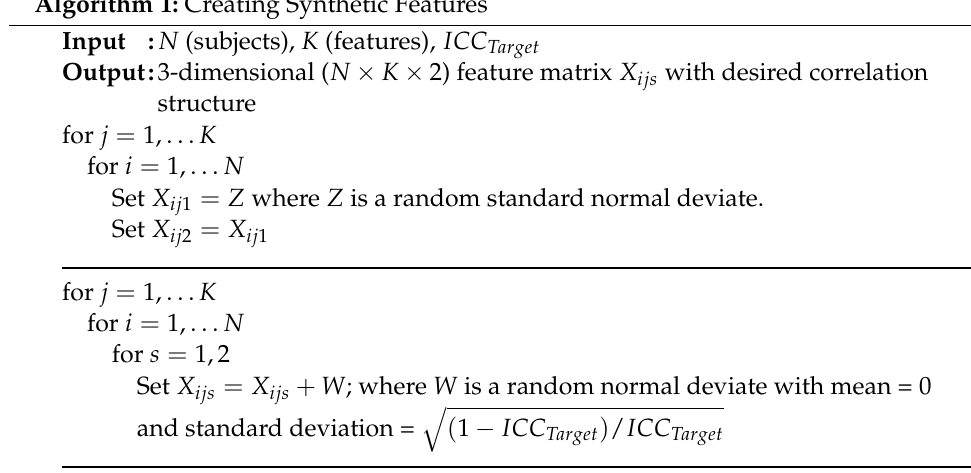
Algorithm 1: Creating Synthetic Features